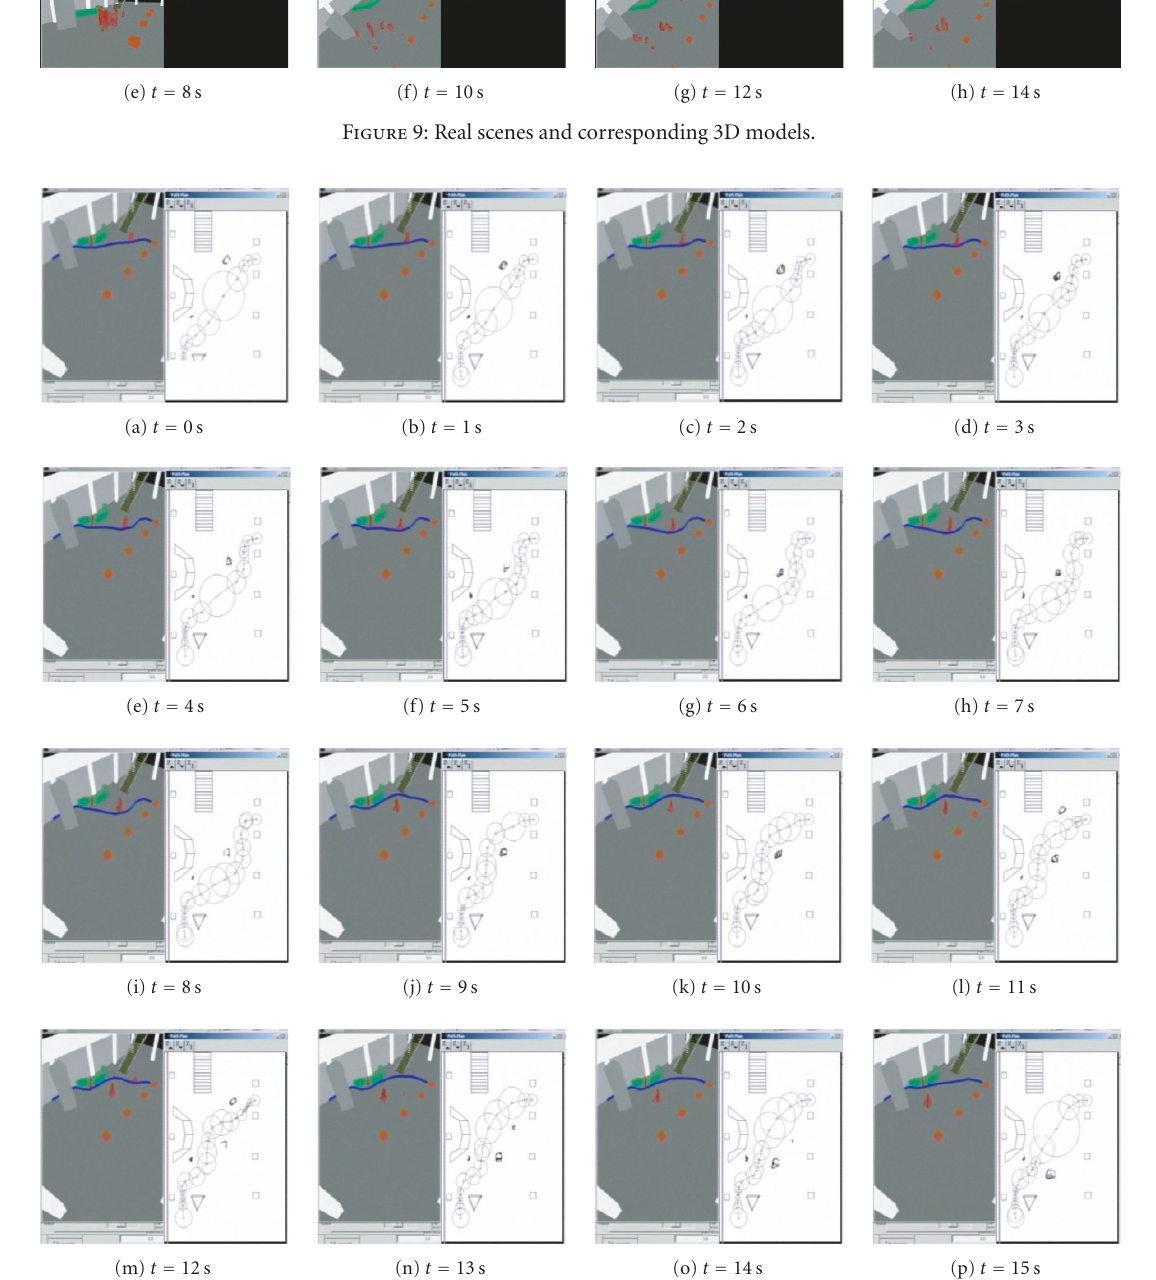
Figure 10: 3D model and corresponding path planning